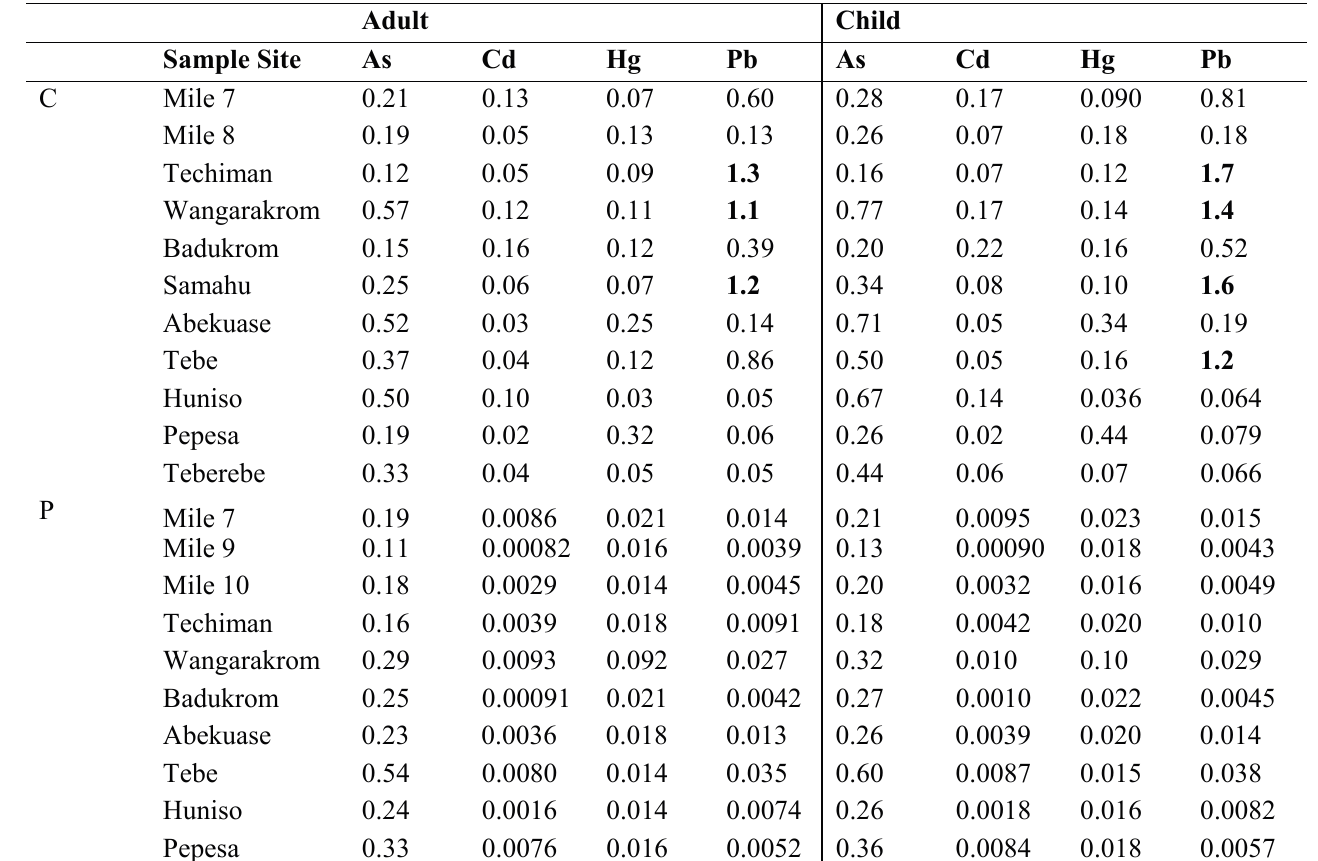
Table 3. Target hazard quotients of toxic metals via foodstuff consumption in